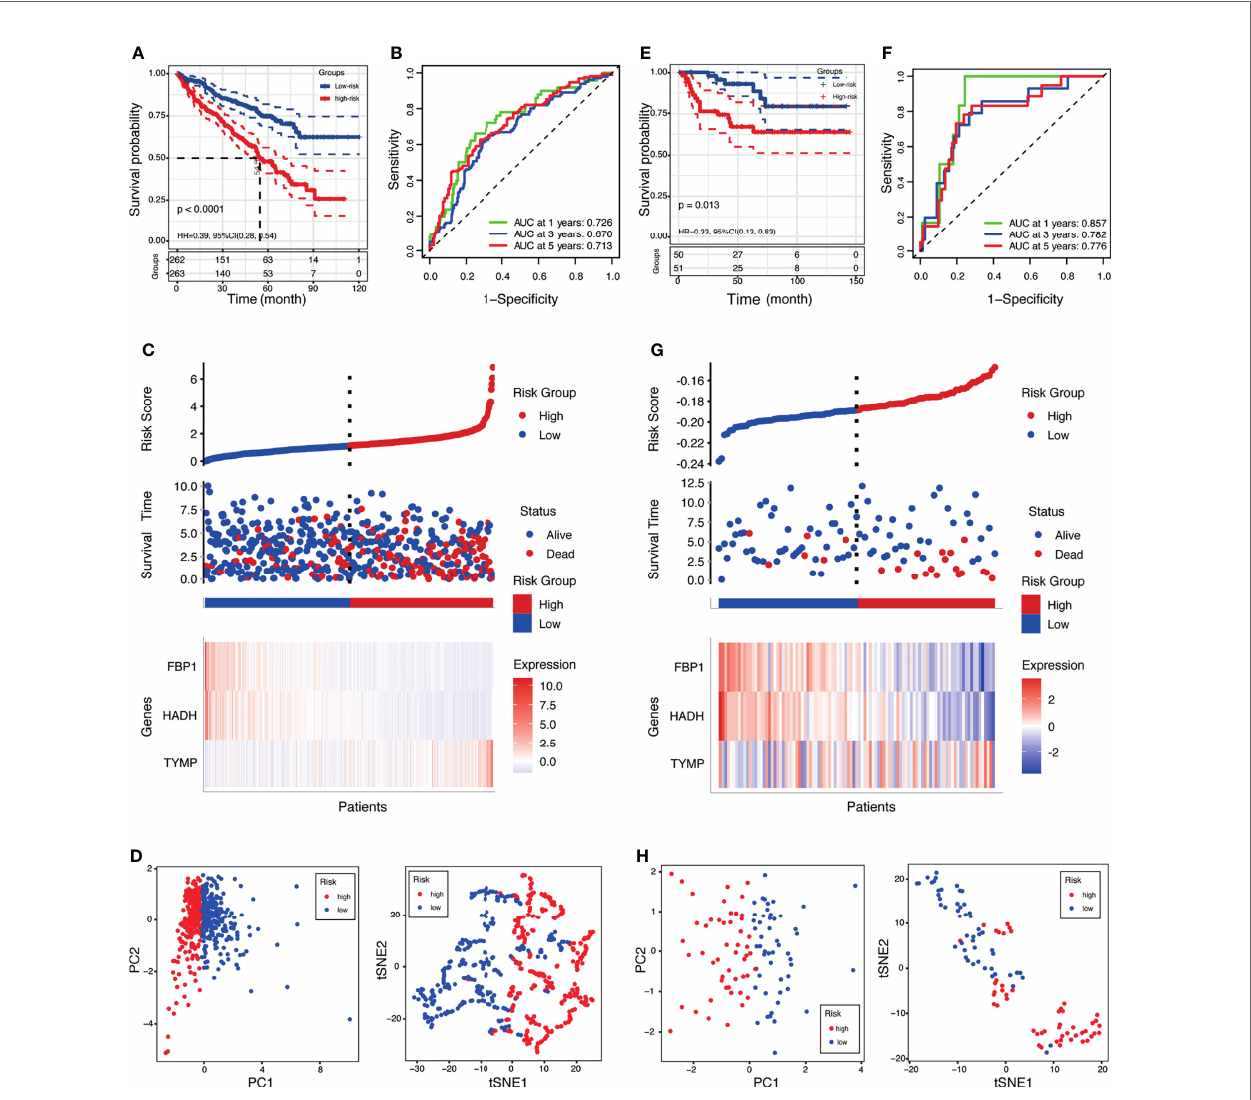
FIGURE 4 | Prognostic value of the lactate-related prognostic signature (LRPS) in patients with kidney renal clear cell carcinoma (KIRC). (A, E) Kaplan – Meier analysis of overall survival (OS) in The Cancer Genome Atlas (TCGA) and E-MTAB-1980 cohorts. (B, F) Receiver operating characteristic (ROC) analysis of the LRPS in predicting the 1-, 3-, and 5-year OS in the TCGA and E-MTAB-1980 cohorts. (C, G) Distribution plots of the risk score, OS status, and heatmap of gene expressions in the TCGA and E-MTAB-1980 cohorts. (D, H) Principal component analysis (PCA) and t -distributed stochastic neighbor embedding ( t -SNE) plot of the TCGA and E-MTAB-1980